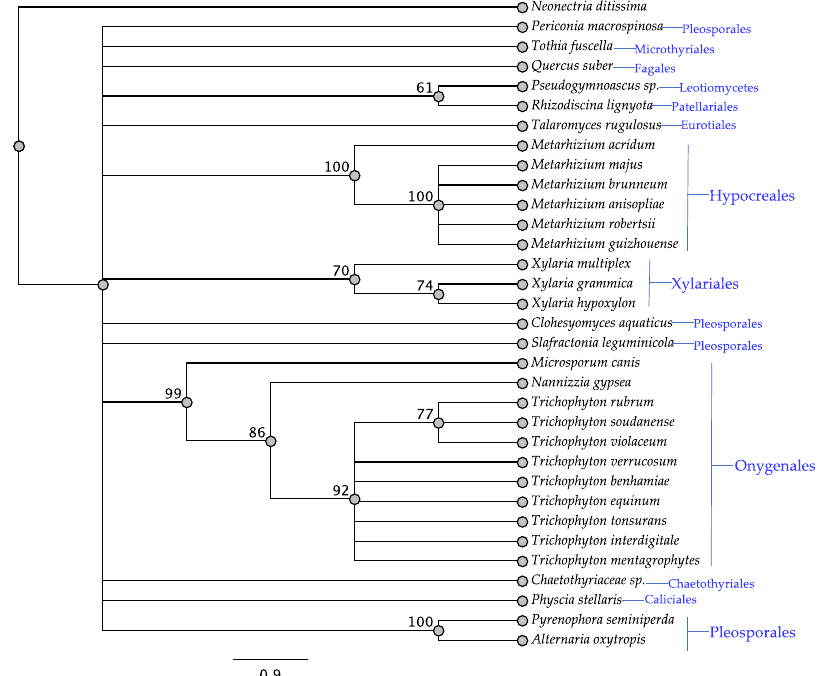
Figure 4. Maximum parsimony protein tree resulting from the analysis of SwnH1. Bootstrap confidence values from 1000 bootstrap replicates are presented at each corresponding node. Neonectria ditissima (Hypocreales) was used as the outgroup and obtained from NCBI database, GenBank accession: KPM44118.1. Fungal orders are indicated next to each organism/clade. The swnR gene was found in all fungi examined except Trichophyton mentagrophytes (Table 1). All taxa that have been reported to contain swainsonine contain swnR (Table 1). In the SwnR tree, only the Hypocreales and Onygenales members formed their own clades. Members of the Pleosporales showed a similar grouping pattern to the SwnK tree in which the Pleosporaceae species ( P. seminiperda and A. oxytropis ) grouped into one clade, and the C. aquaticus and S. leguminicola grouped into another clade (Figure 5).